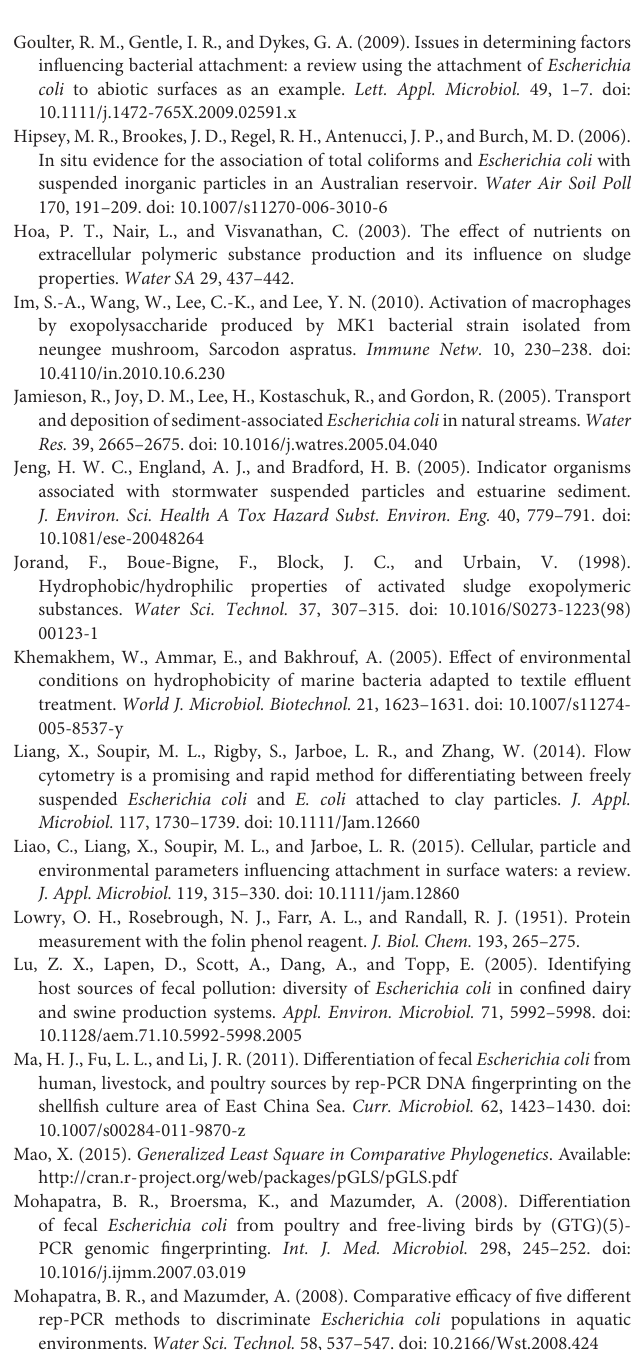
charge of E. coli strain = pH 5.8; (2) Net charge at pH 8.0 carried by E. coli = − 7.5 × 10 − 6 meq/10 8 cells; (3) Total acidity of E. coli strain = 2.8 × 10 − 5 meq/10 8 cells. FIGURE A2 | The dendrogram shows the percent similarity of rep-PCR fingerprint banding patterns for 78 strains with similarity smaller than 90%, based on UPGMA cluster analysis. Strains 1–200 (italic and bold) were collected from stream sediment, while 201–400 were collected from stream